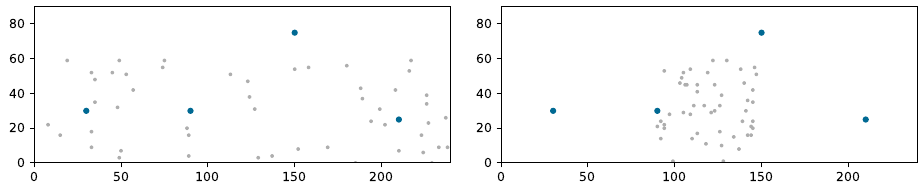
Figure 1. Two representations of the simulation environment where the distribution of mobile nodes is more uniform ( left ) and more centered ( right ).